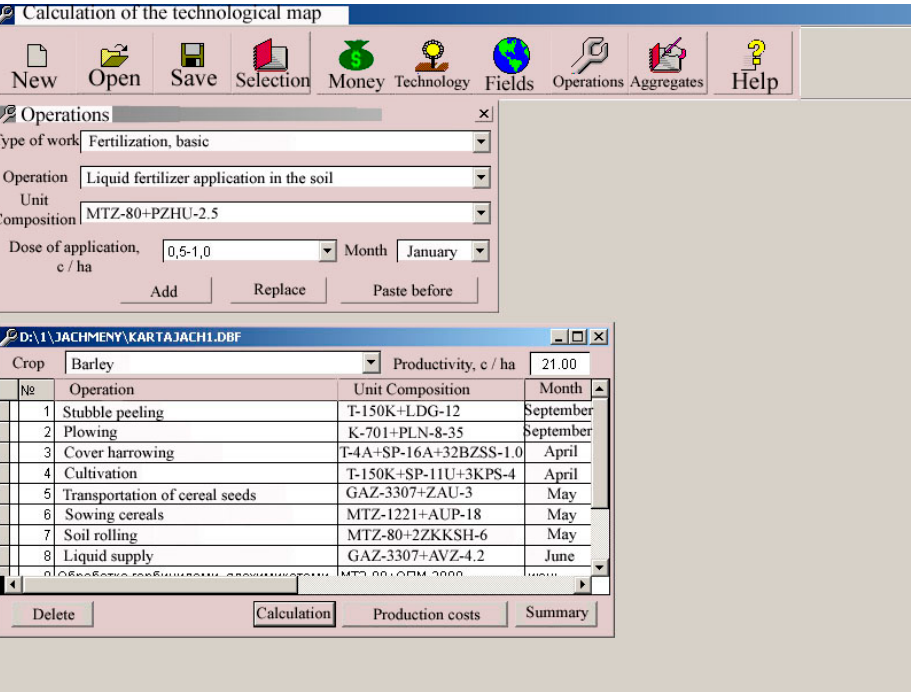
Figure 1. An example of filling in the initial information for calculating the technological map in crop production.